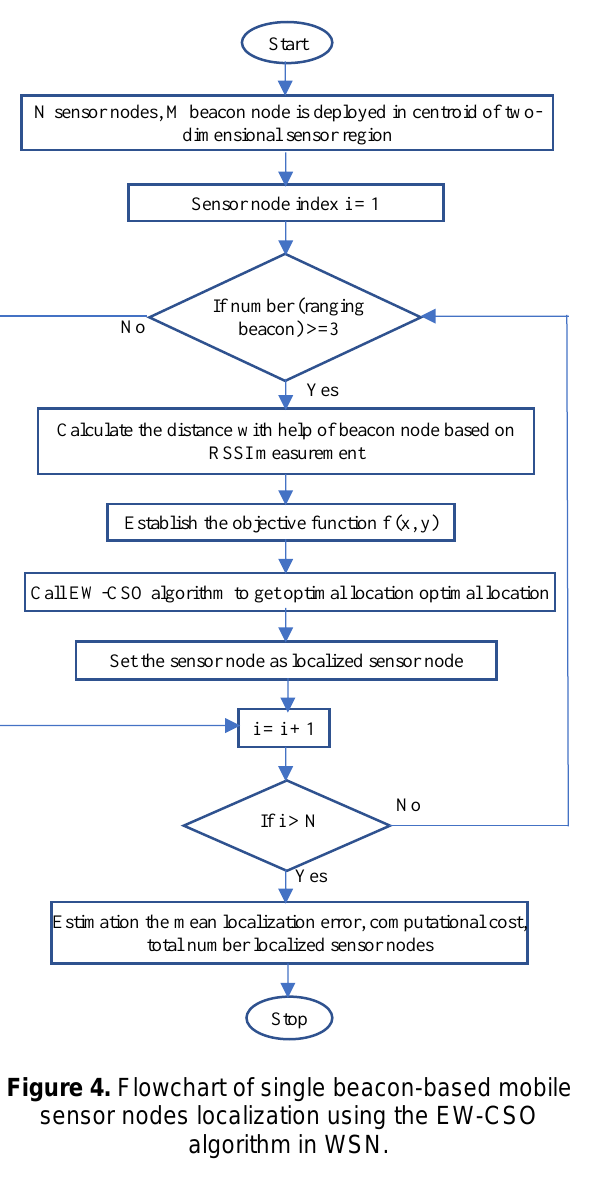
Figure 4. Flowchart of single beacon-based mobile sensor nodes localization using the EW-CSO algorithm in